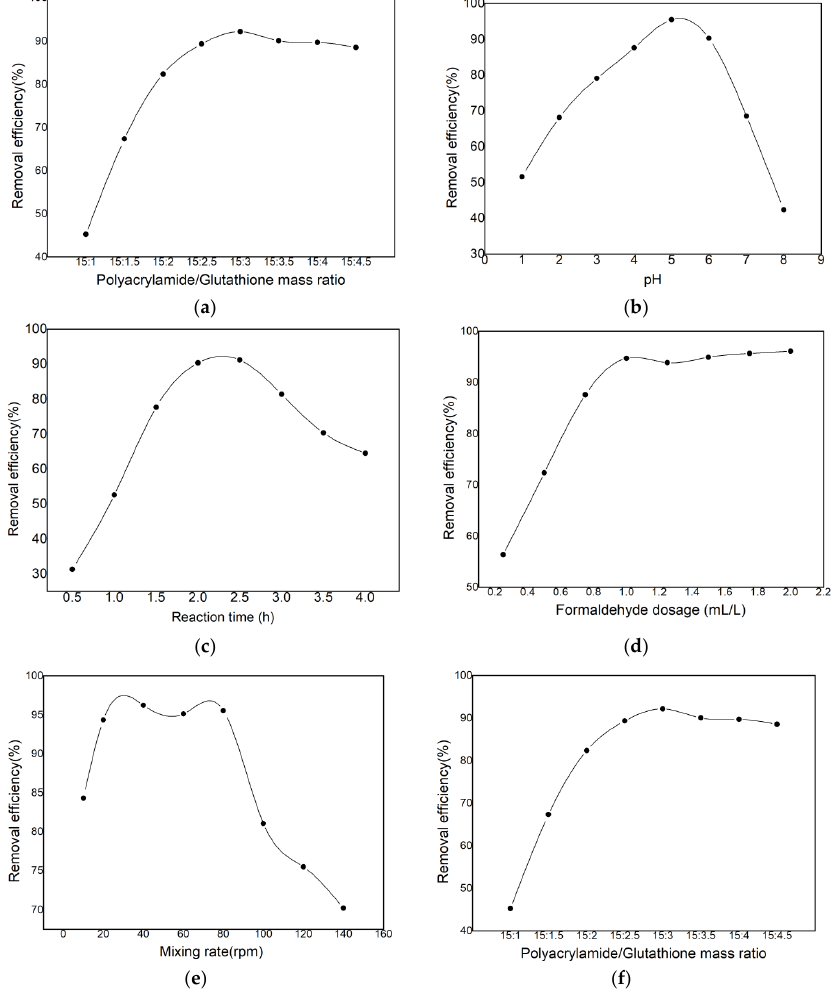
Figure 1. Effect of synthesis conditions on the cadmium removal rate of polyacrylamide–glutathione ( a ) m(polyacrylamide)/m(glutathione)ratio, ( b ) reaction time, ( c ) pH, ( d ) formaldehyde dosage, ( e ) mixing rate, and ( f ) temperature.